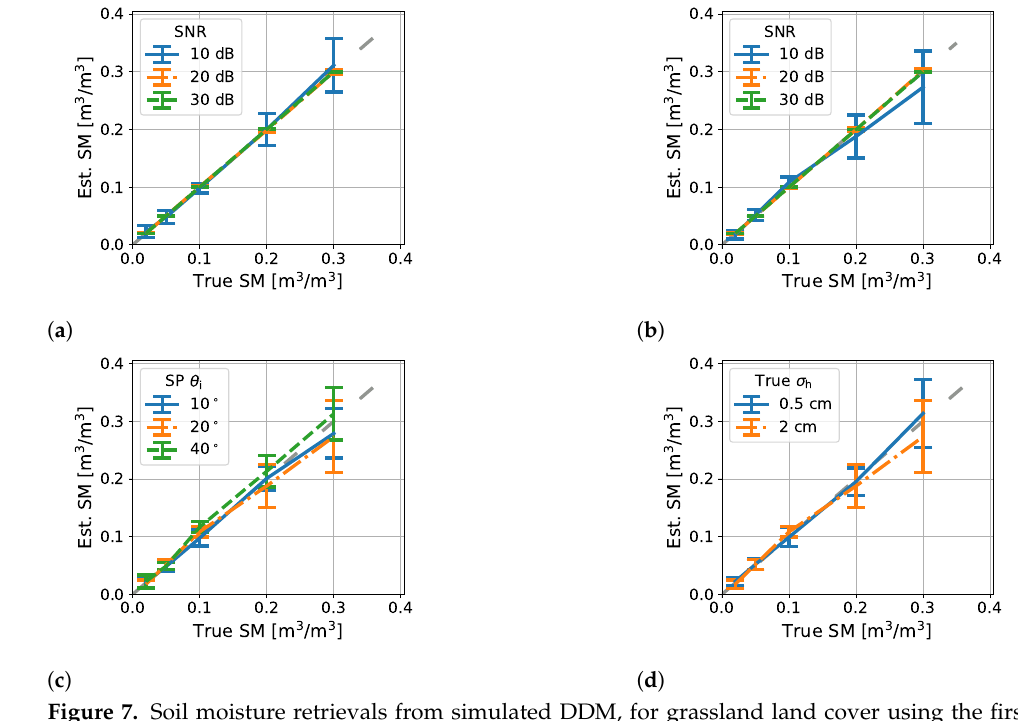
= 2cm, θ SP = 2cm, SNR = 10dB. = 10°. ( b ) σ = 20°. ( c ) σ h h i i